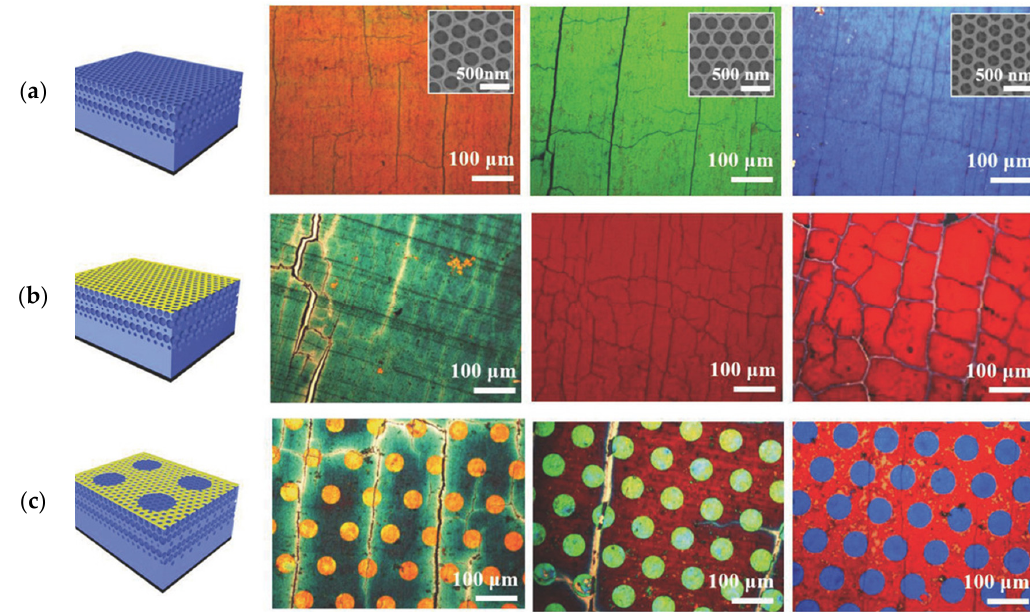
Figure 3. The models (first column) of the: ( a ) IO, ( b ) Au layer-deposited IO, and ( c ) micropatterned IO by local Au deposition; and respective optical microscopy images for different sizes of SiO 2 NPs, i.e., with diameter of 315 nm (the second column), 290 nm (the third column) and 239 nm (the fourth column), used as a template (opal); Reprinted with permission (after formatting) from [104]. Copyright (2018) WILEY.